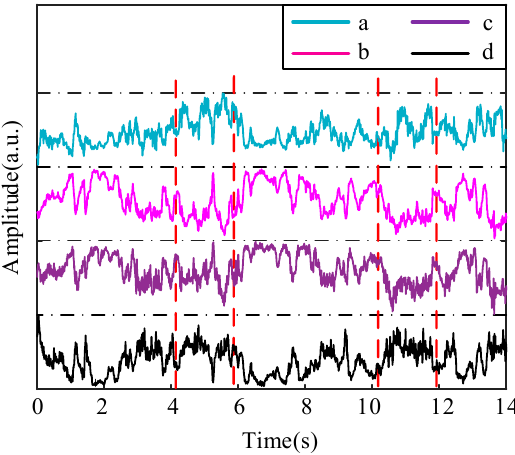
Figure 13. The resulting coefficients after processing by the algorithm, where four kinds of lines represent the different coefficients a , b , c and d , respectively. To make the results more clear, the ranges of values are omitted in the figure.